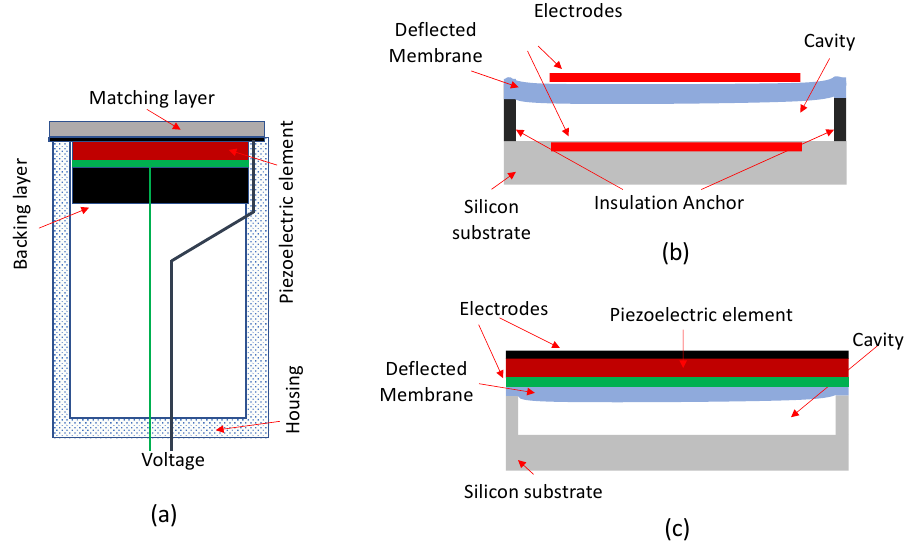
Figure 1. Typical schematic view of cross-sectional structures of ( a ) piezoelectric ultrasonic transducers; ( b ) capacitive micromachined ultrasonic transducers (cMUTs) and ( c ) piezoelectric micromachined ultrasonic transducers (pMUTs) transducers.